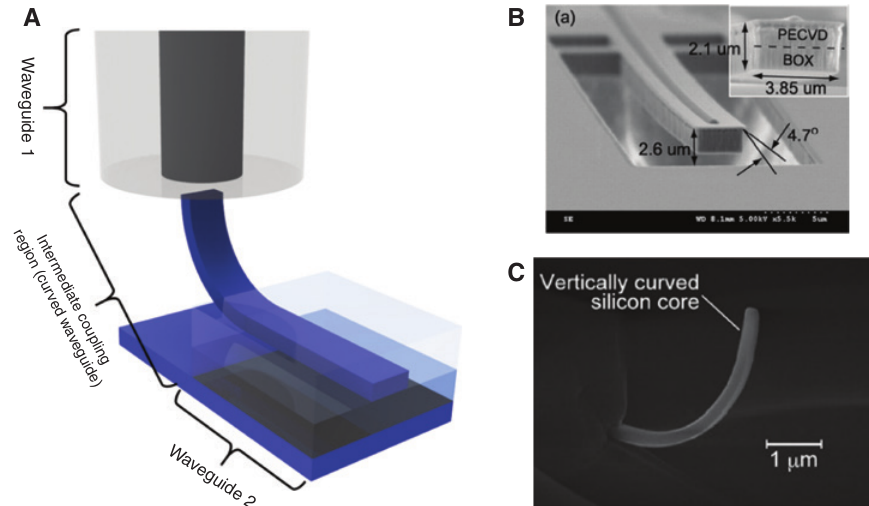
Figure 7: (A) Schematic diagram of a vertically curved intermediate waveguide structure. (B) SEM image of a curved coupler using